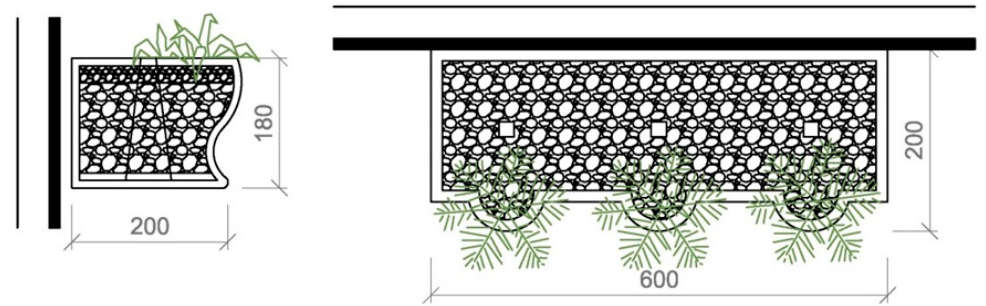
Figure 4. Detail of a segment of experimental green